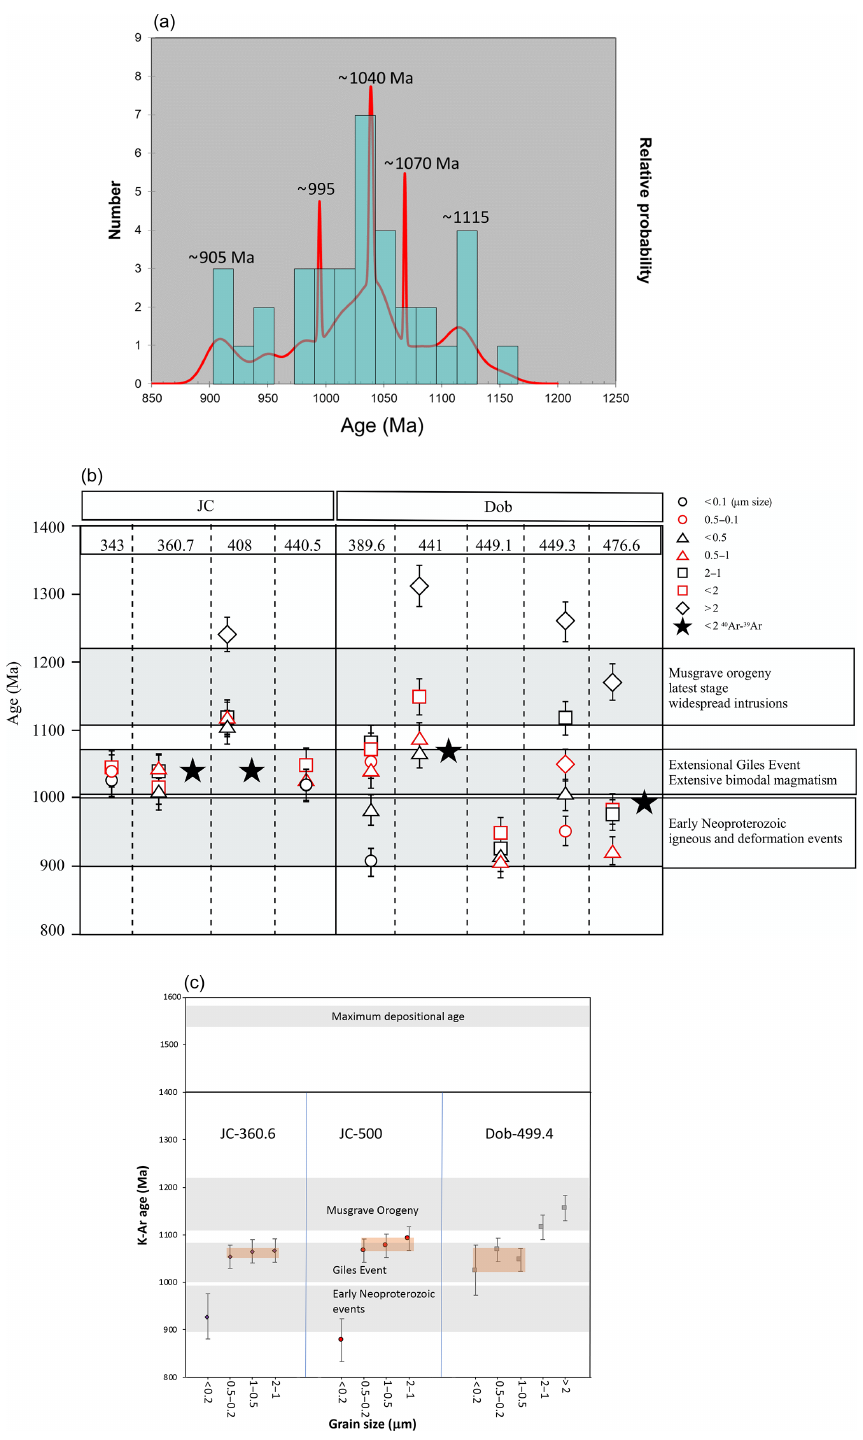
Figure 7. (a) Histogram for K–Ar and Ar–Ar ages and probability distribution of ages for fault gouge illites. Curves show relative proba- bilities calculated using Isoplot 7 for Excel (Ludwig, 2012). (b) K–Ar and Ar–Ar dates (no error bars due to small errors) for different size fractions of fault gouges and (c) matrix illites from host rocks and their interpretation in relation to tectonic